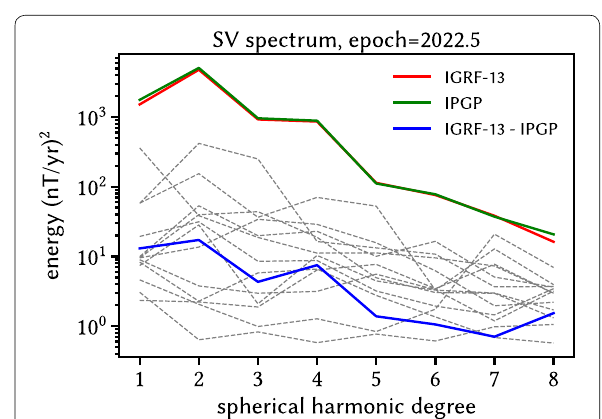
Fig. 6 Mauersberger–Lowes spectra of the secular variation of the IGRF-13 SV model, the IPGP candidate and their difference at Earth’s surface (thick solid lines). Also shown are the spectra of the differences between the IGRF-13 SV model and the 13 other candidates that were submitted in response to the IGRF call (grey dashed